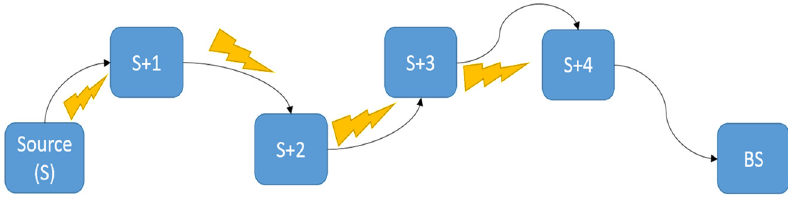
Figure 12. Testbed layout. The arrows represent DATA packets, and the bolts represent monitoring the neighbour node’s DATA sending